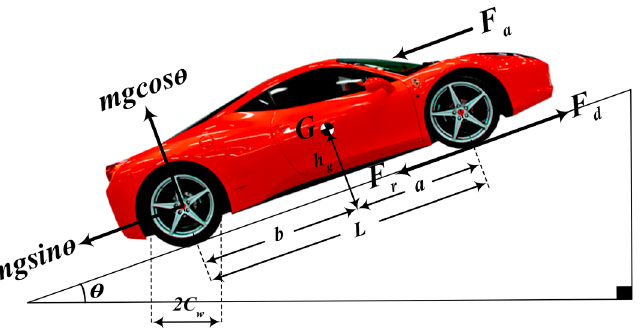
Figure 4. Forces acting against the EV during driving and two-axle braking dynamics of the EV [5].